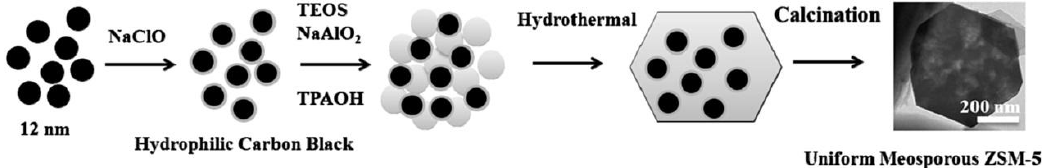
Figure 10. Synthesis scheme of mesoporous ZSM-5 using hydrophilic carbon as template [83]. Copyright Elsevier, 2016.